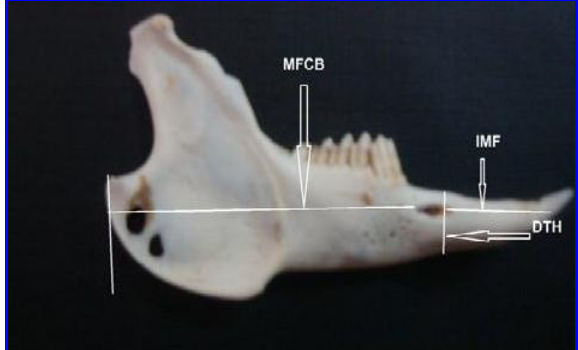
Figure, 3: The lateral surface of mandible of local rabbit showing the measurements reported in (Table, 1). Distamal thickness (DTH): Distance between the dorsal and ventral Distamal border. Mandibular foramen caudal border (MFCB): the distance between mandibular foramen and caudal border. Incisor-mental (IMF): Shortest distance from incisor to mental